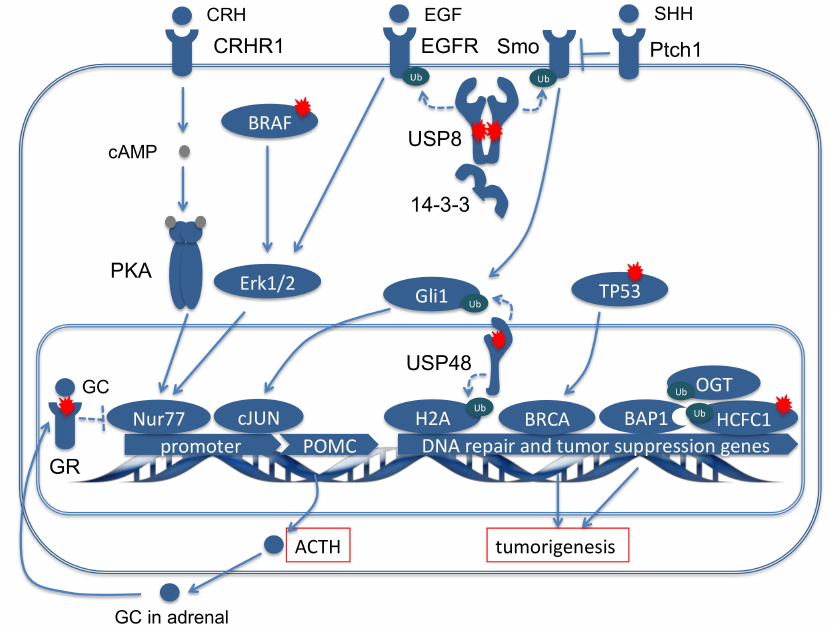
Figure 4. Graphic representation of all independent recurrent mutations in the context of a corticotroph pituitary cell in Cushing’s disease. In blue are represented the di ff erent proteins and factors that are involved in di ff erent processes in a cell. The independent recurrently mutated genes are marked with red sparks. The interactions are based on literature and should visualize direct and indirect involvement of the mutations in the cellular processes in a Cushing’s pituitary cell. Doted arrows indicate hypothesized mode of action of these